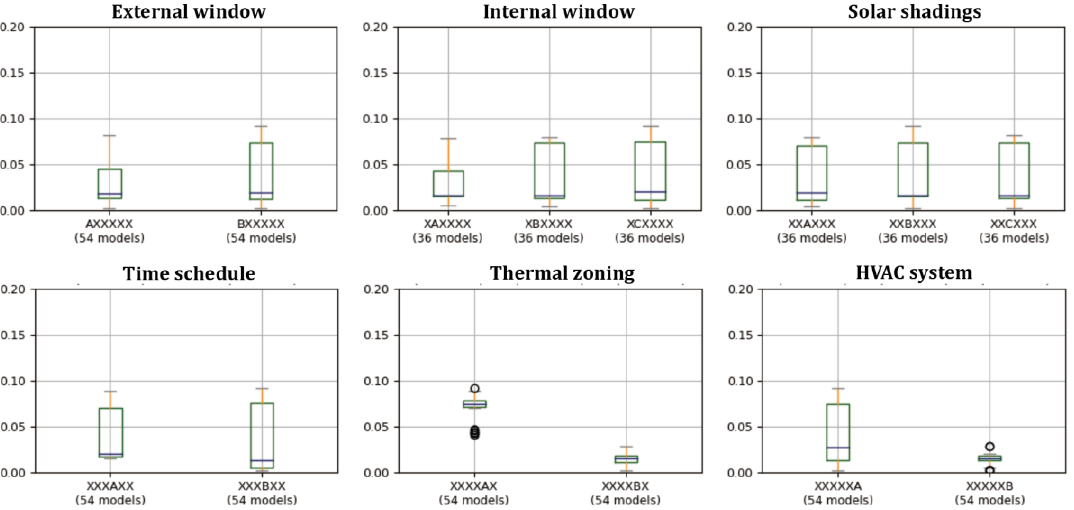
Figure 10. The boxplot for the six input parameters for the building against the CVRMSE of the zone mean air temperature. Table 6. The analysis of U-testing for the CVRMSE boxplot (zone mean air temperature).